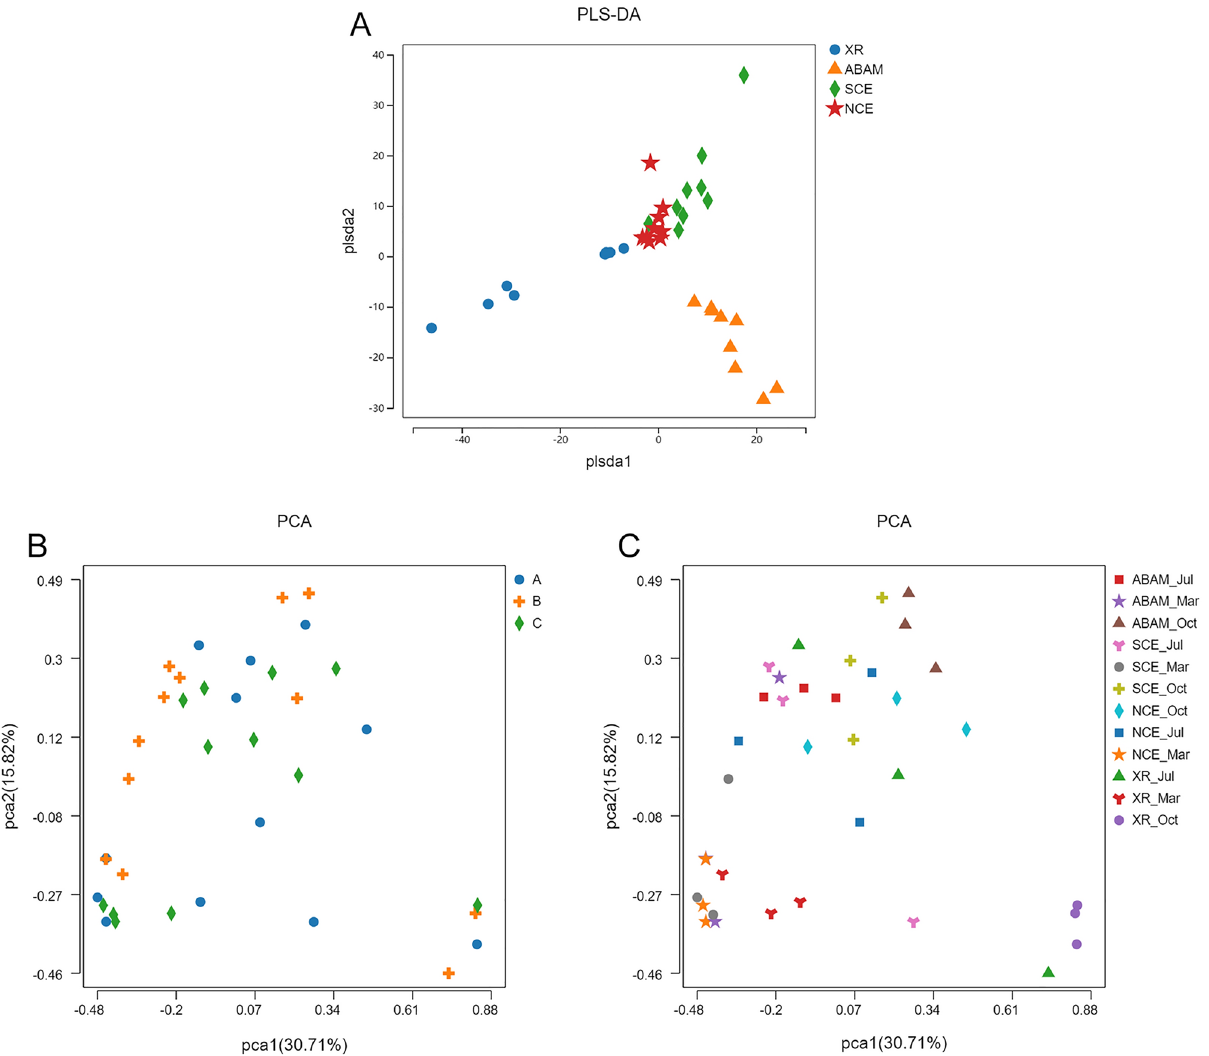
Figure 8. Outline diagram of ABR